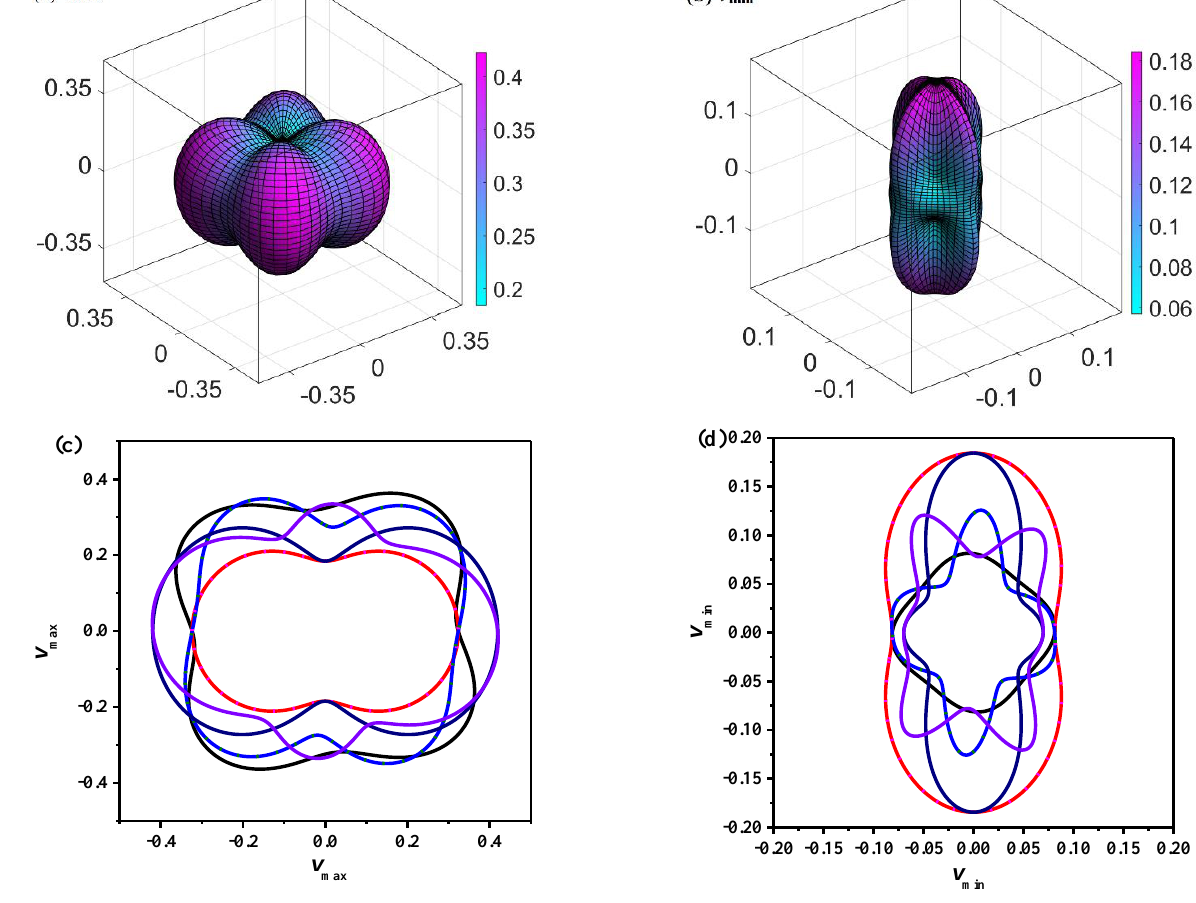
Figure 5. The directional dependence of the maximum values for Poisson’s ratio for P 4/ m BN ( a ), the minimum values for Poisson’s ratio for P 4/ m BN ( b ), the 2D representation of the maximum values for Poisson’s ratio for P 4/ m BN ( c ) and the 2D representation of the minimum values for Poisson’s ratio for P 4/ m BN ( d ).